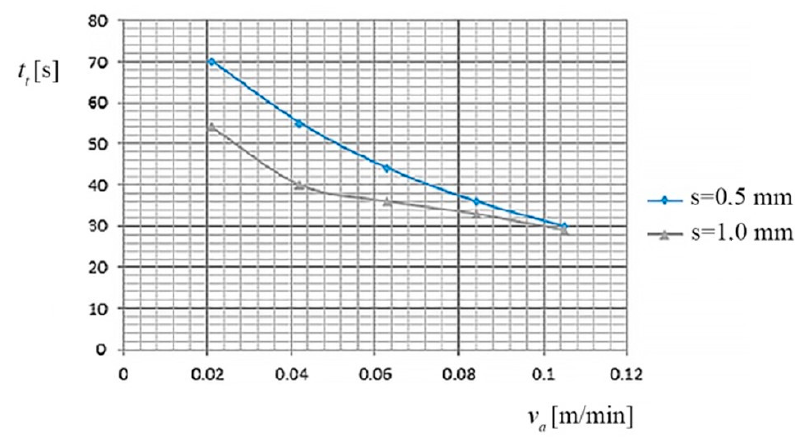
Figure 2. Dependence of the t t , on v a of the Processing Object (PO) and on the thickness ( s ) of the metal band. Table 3. The dependence of the cutting time, the feed rate of the Processing Object (PO), and the thickness of the metal band. Table 4. The dependence of the width of the cut, on the relative speed of the Transfer Object (TO), and on the thickness of the metal band.